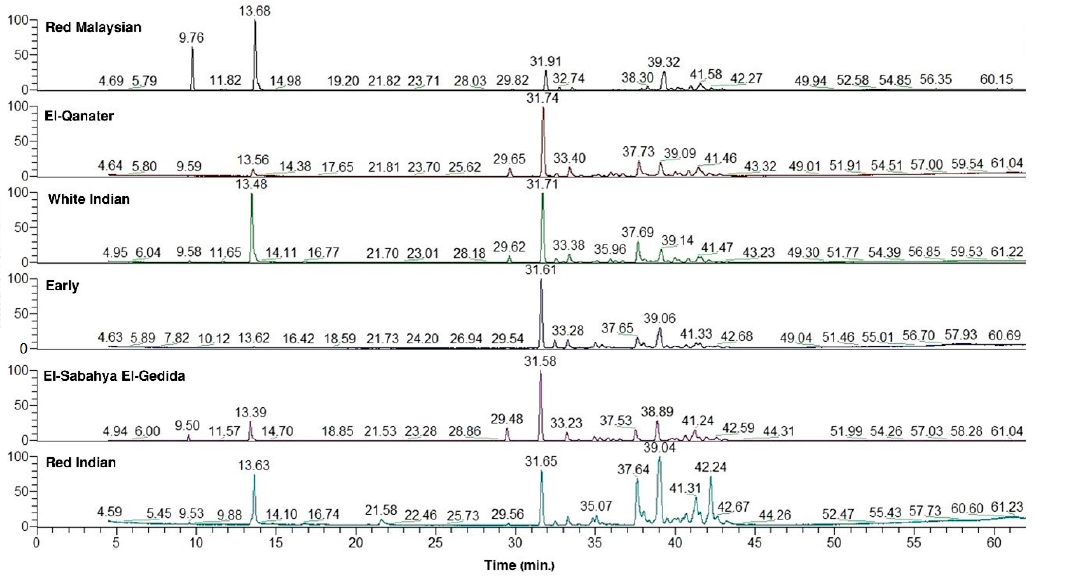
Figure 1. Gas chromatography–mass spectrometry (GC-MS) chromatogram of the essential oils (EOs) from the leaves of the six studied varieties of Psidium guajava .